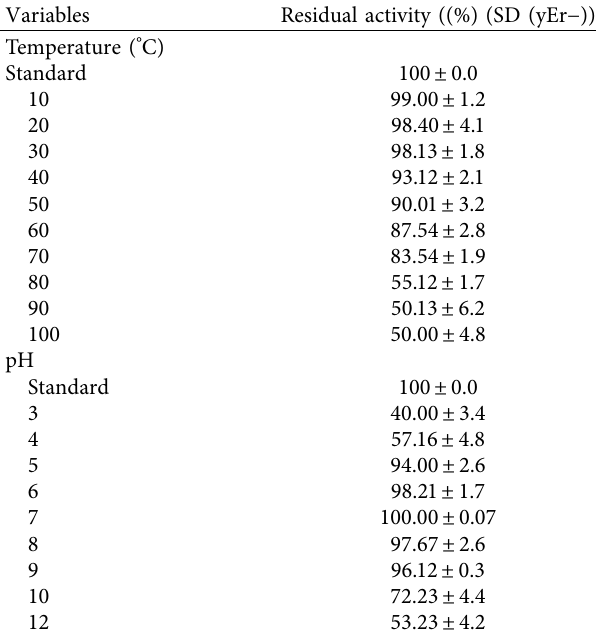
Figure 1: FT-IR spectrum of purified alpha-amylase. Table 1: Stability characterization of